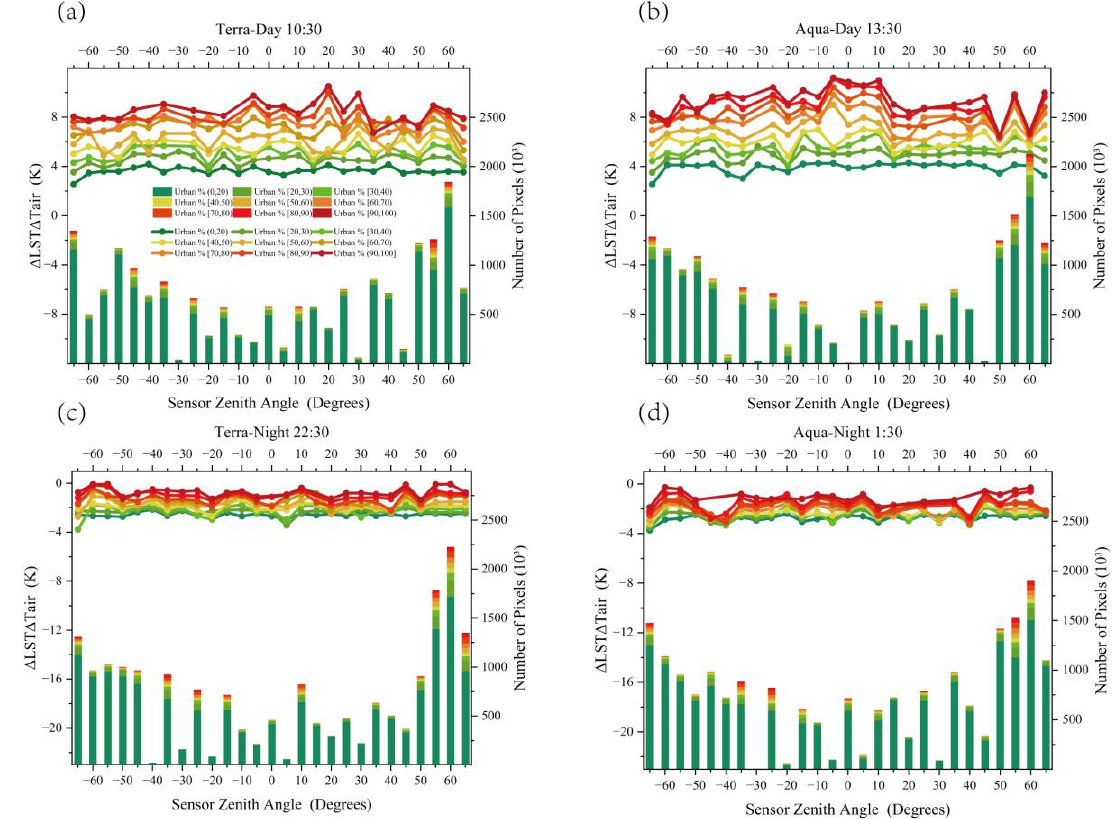
Figure 4. Statistical distribution of average ∆ LST ∆ T of each zenith angle, under different land-use intensities, at each satellite overpass time for Hefei. The right y -axis is the number of pixels with different land-use intensities of each SZA (represented by a histogram); the left y -axis is the average ∆ LST ∆ T air of each SZA, under different land-use intensities (represented by a line chart). The subfig- ures ( a – d ) illustrate the statistical distribution of the average ∆ LST ∆ T for each zenith angle under different land-use intensities during satellite overpass at 10:30, 13:30, 22:30, and 01:30, respectively.